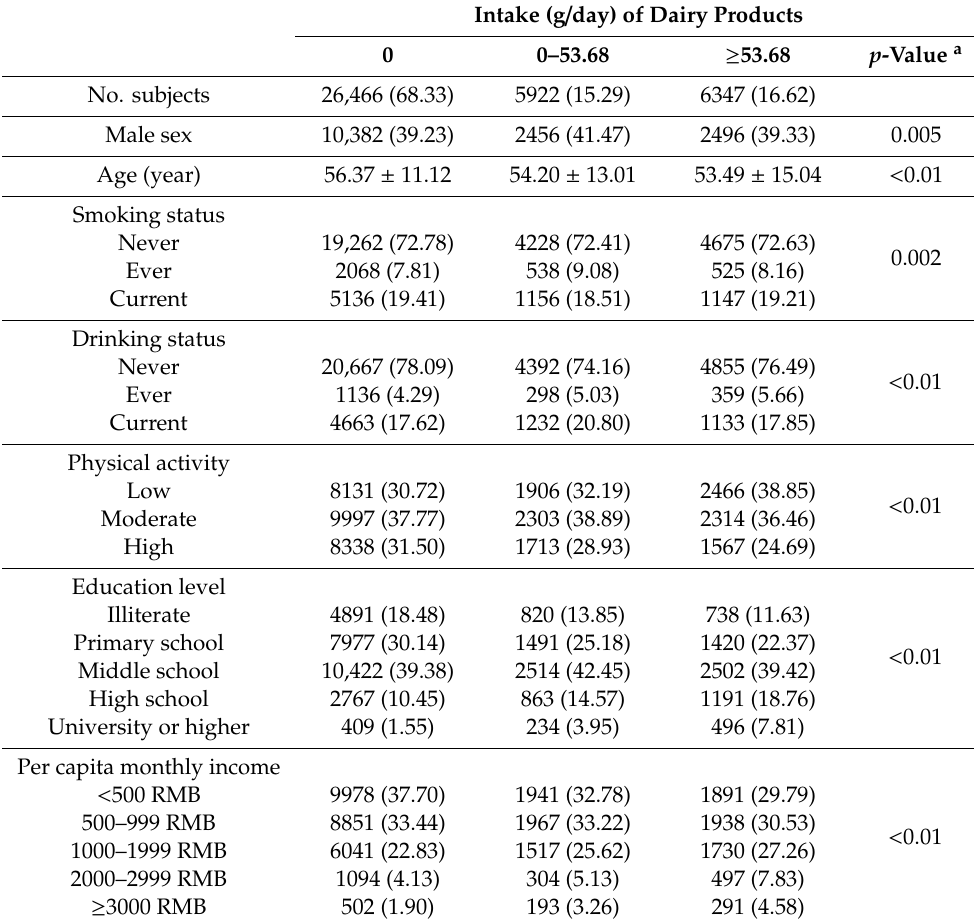
Table 1. General characteristics of participants ( n = 38,735 in total) of the Henan Rural Cohort Study according to total intake of dairy